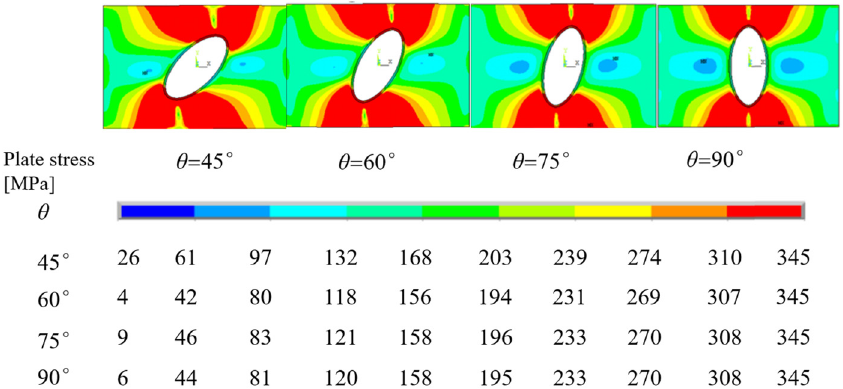
Figure 11: Stress distribution of the fl anged perforated plates with t = 8 mm in the ultimate state.